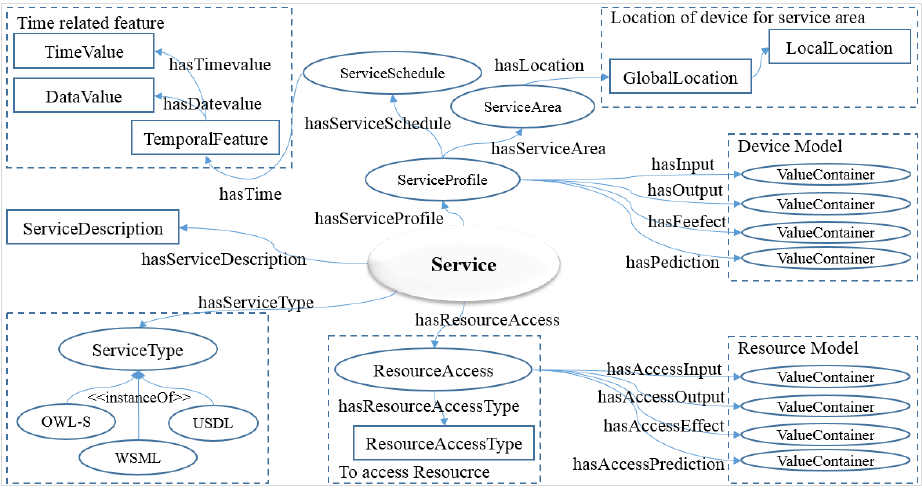
Figure 6. Service model in semantic ontology that describes the profile of service